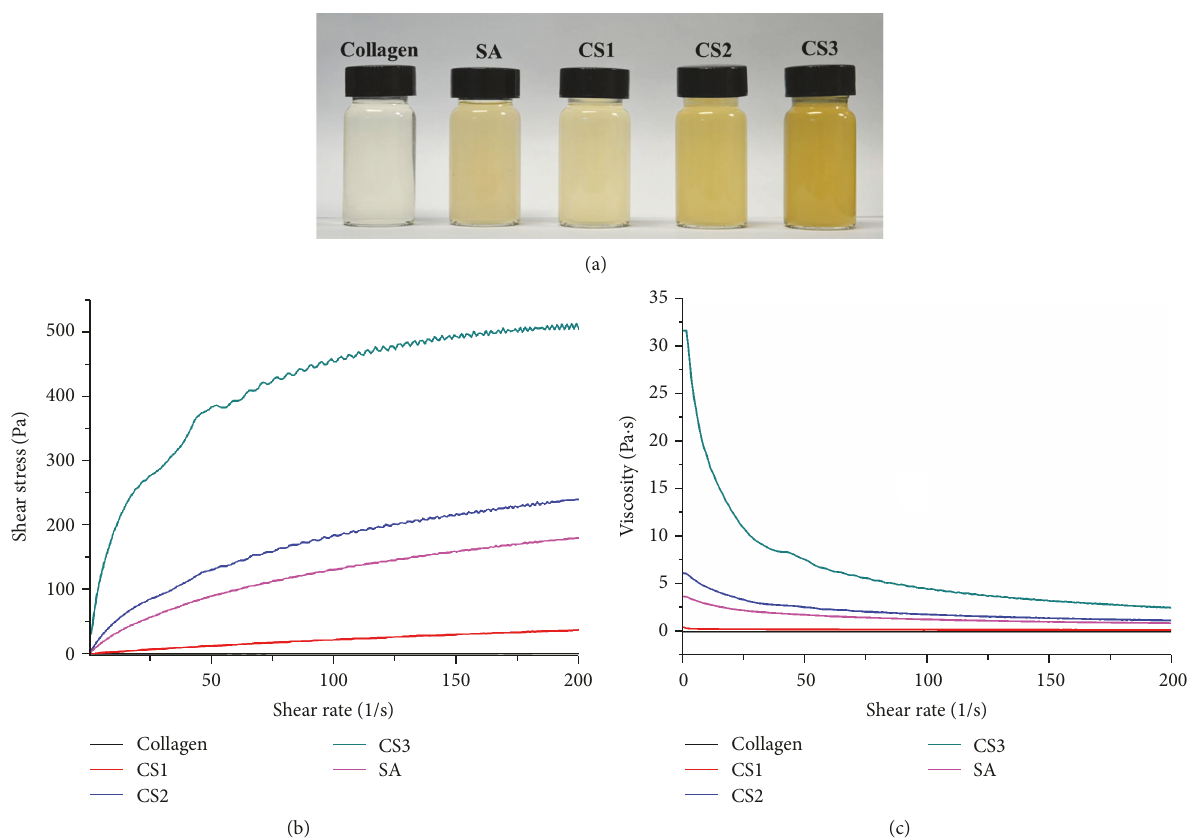
Figure 2: Characterization and rheological property evaluation for the films, (a) film-forming solution macrograph, (b) sheer stress versus shear rate, and (c) viscosity versus shear